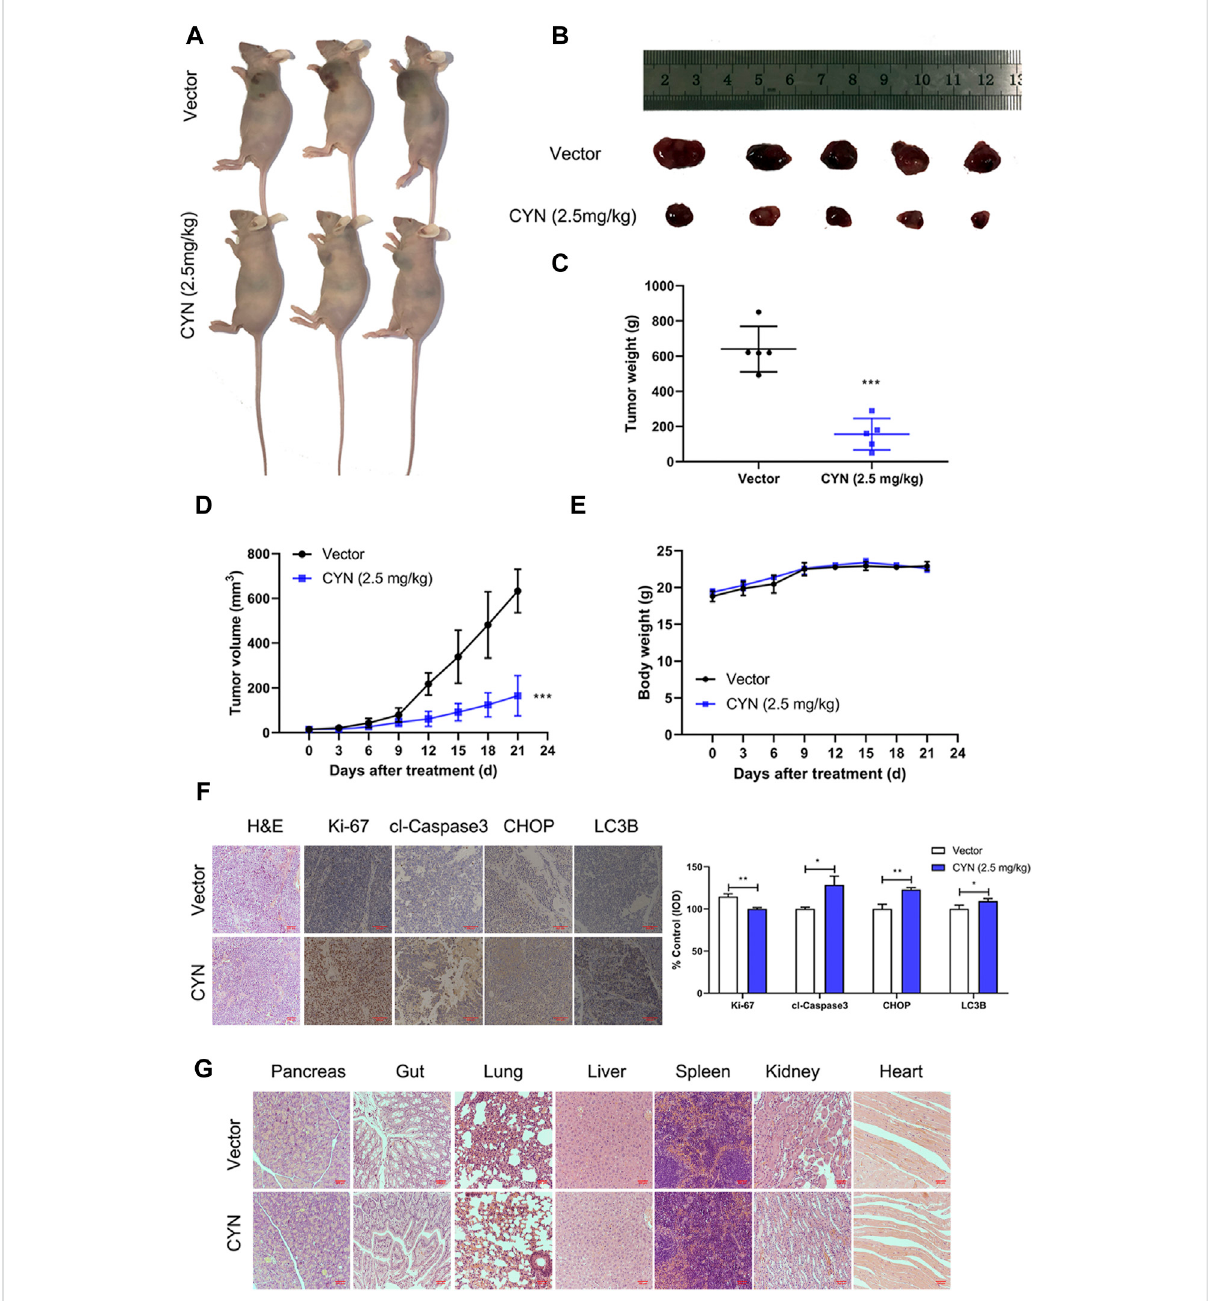
FIGURE 7 Effects ofCYNon theNB tumorgrowth inathymicnudemice. (A , B) Representative imagesofxenograft tumorswereshown. (C) Tumorweight after3 weeksoftreatment withCYN. (D) TumorvolumeduringadministrationofCYN. (E) Theweightofmicewasmonitoredduring theexperiment. (F) IHC staining results detected and analyzed the expression of Ki-67, cl-Caspase3, CHOP and LC3B. (G) HE stains examined the histopathologic characteristics of pancreas, gut, lung, liver, spleen, kidney and heart. * p < 0.05, ** p < 0.01, *** p < 0.001 versus the vector